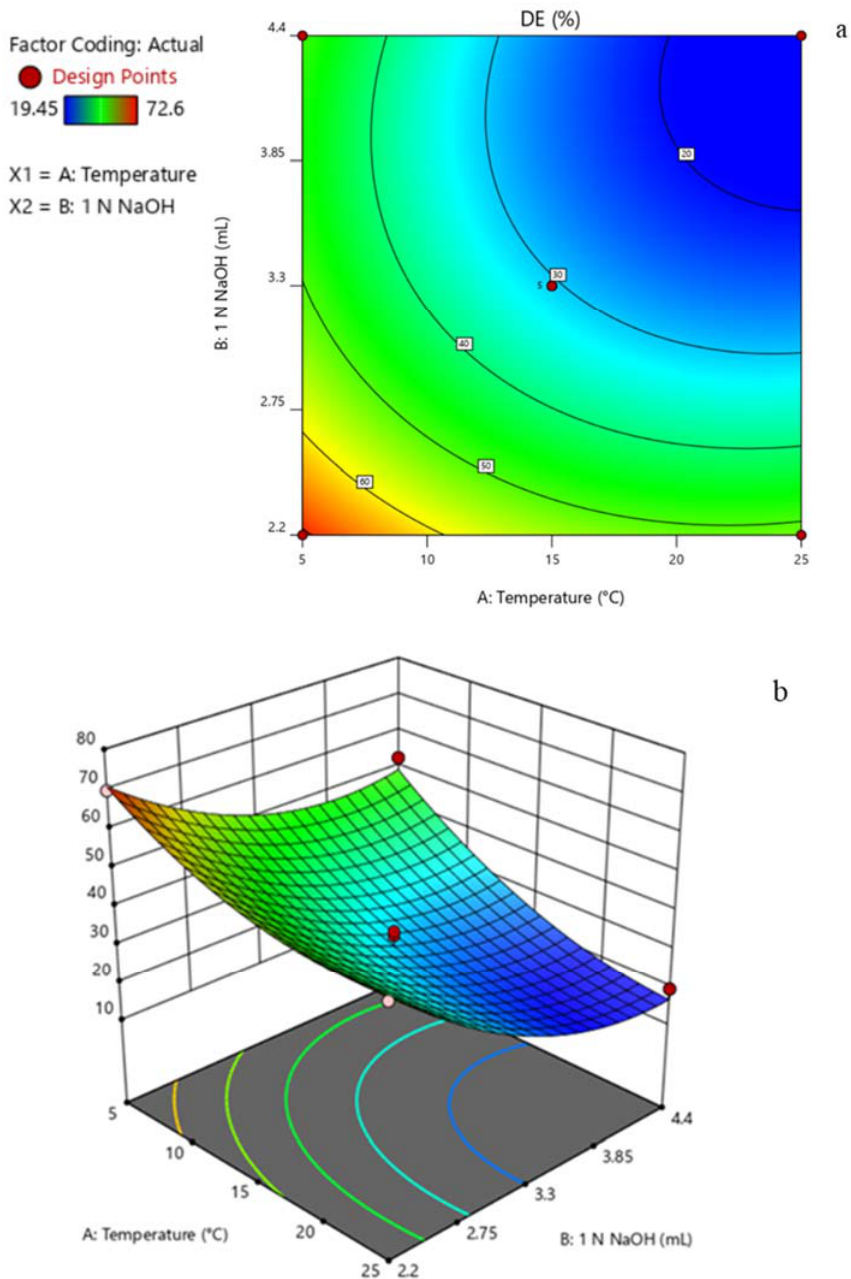
Figure 4. Response surface showing the effect of the temperature and volume of 1 N NaOH in a level of experiment on DE of de-esterified pectin. ( a ) contour response; ( b ) 3D response.